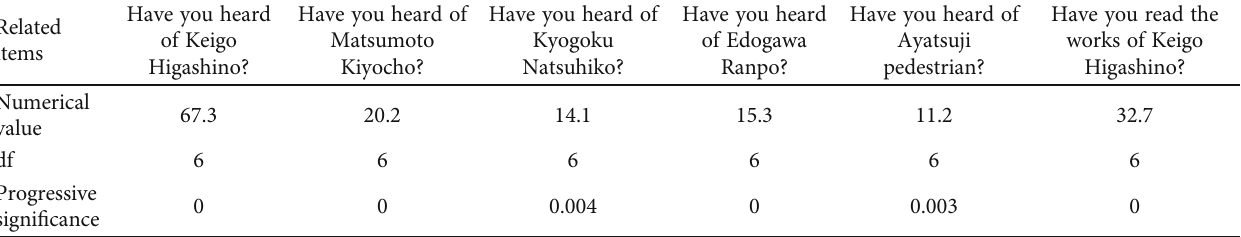
Table 3: Chi-square test of readers ’ cognition of Japanese literature and the degree of pleasure in reading Japanese literature. Related